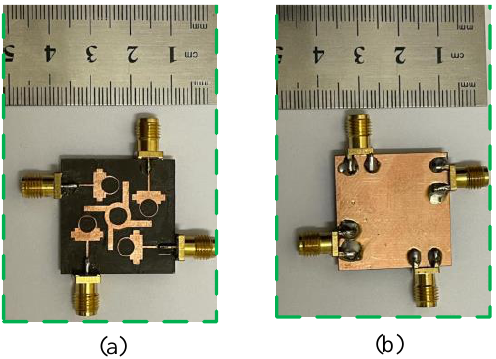
Figure 9. Hardware prototype of proposed parasitic element-loaded 4-port MIMO antenna for 28/38 GHz millimeter-wave applications (a) top side (b) bottom side